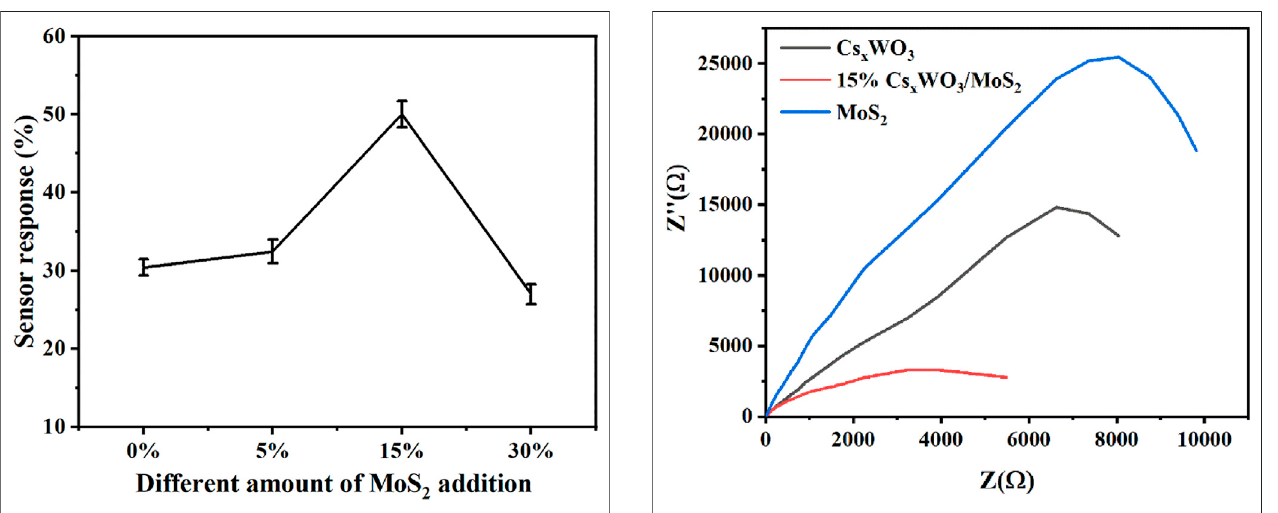
FIGURE 11 | Electrochemical impedance spectra of Cs x WO 3 , MoS 2 , and 15% Cs x WO 3 /MoS 2